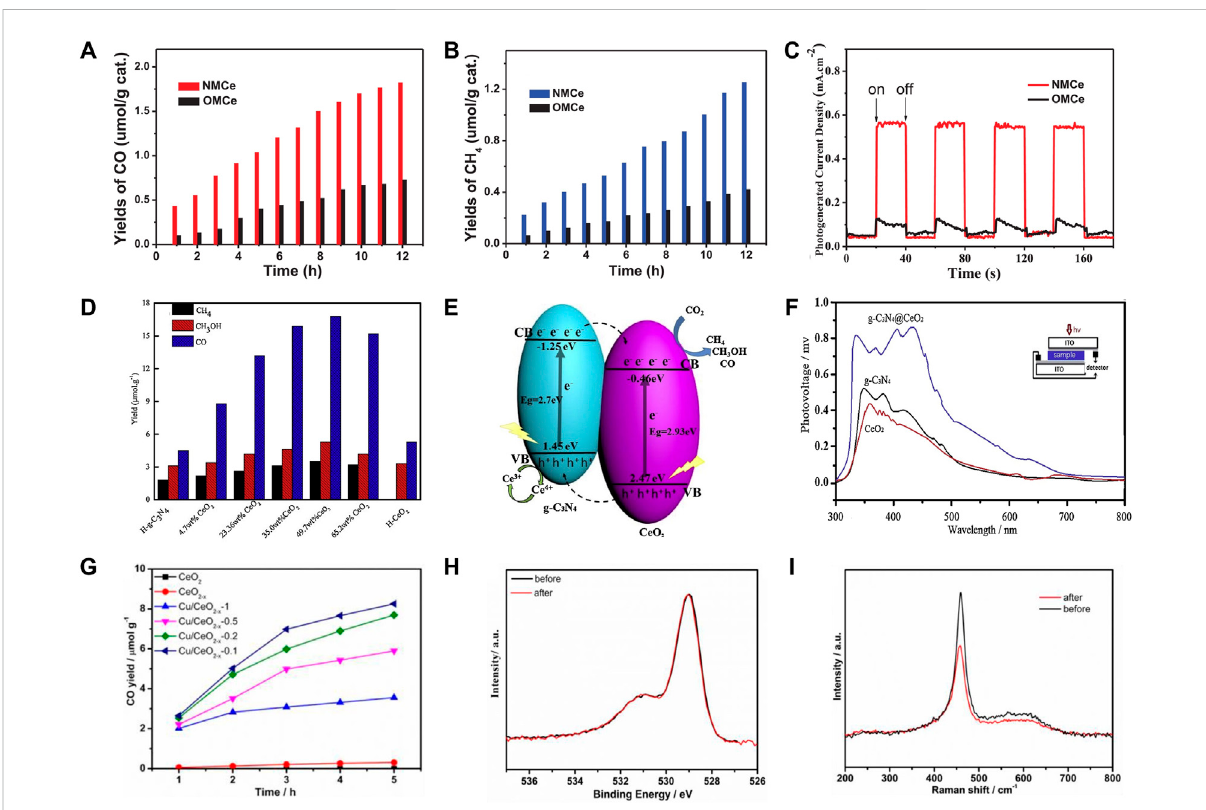
FIGURE 7 Design of CeO 2 -based photocatalysts for photocatalytic CO 2 conversion: (A – C) A nitrogen-doped mesoporous CeO 2 (NMCe) as an ef fi cient visible-light-driven catalystfor